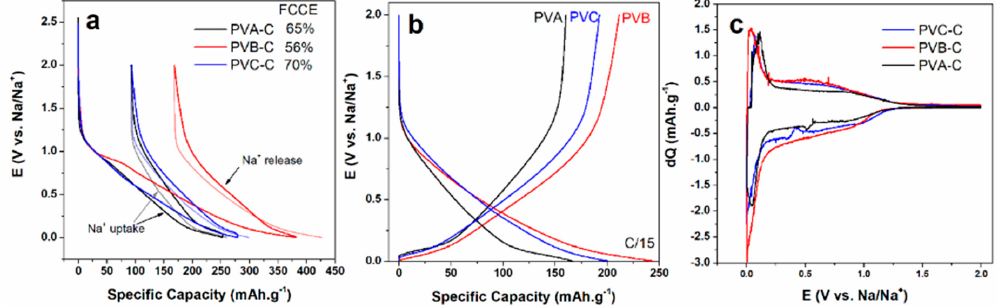
Figure 3. The sodium storage capability of the polyvinyl-derived soft carbons in a three-electrode configuration in 1 M NaClO 4 in EC:PC solution: ( a ) (Dis)charge profiles of the sample at C/15 (C = 372 mA·g − 1 ); ( b ) second (dis)charge profiles of the samples; and ( c ) derivative curve, dQ vs. potential, of the samples at C/15.